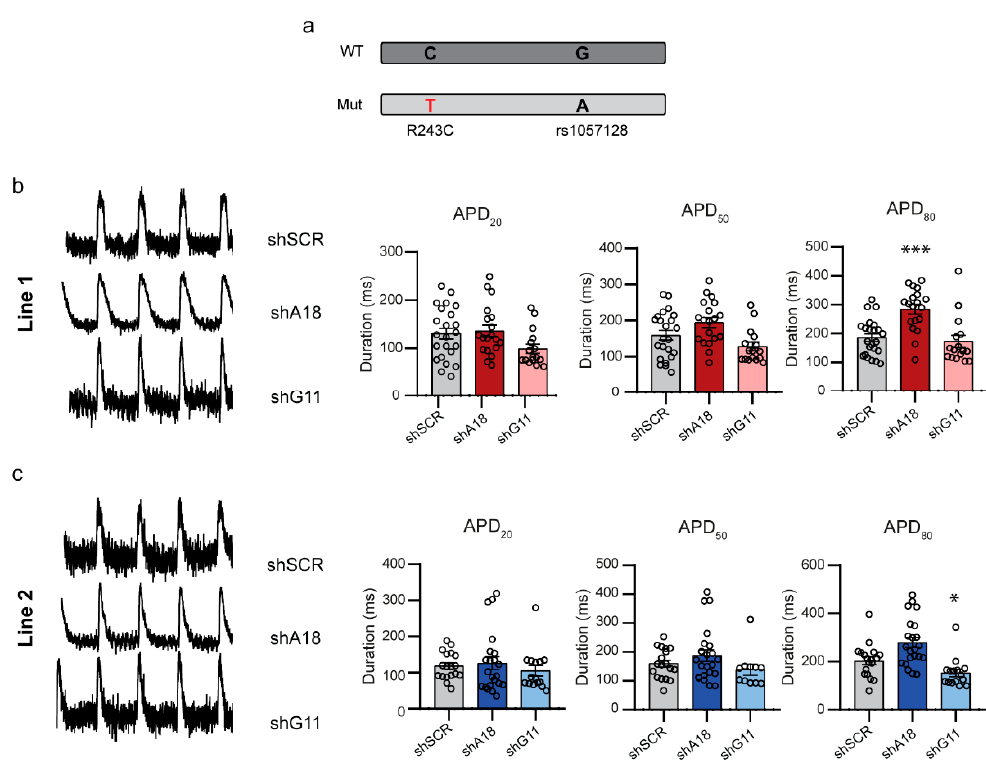
Figure 3. Action potential duration is affected by shifts in allelic balance: ( a ) Schematic representation of the SNP and mutation in KCNQ1 ; ( b , c ) Left, typical recordings of optical action potentials derived from ArcLight fluorescence changes in hiPSC-CMs from Line 1 ( b ) or Line 2 ( c ) treated with either negative control shSCR, shA18 targeting the mutant KCNQ1 allele or shG11 targeting the wild-type KCNQ1 allele stimulated at 1 Hz. Right, action potential duration at 20, 50, or 80% of repolarization (APD 20 , APD 50 , and APD 80, respectively) of optical action potentials of hiPSC-CMs from Line 1 in red ( b ) or Line 2 in blue ( c ). * p < 0.05; *** p < 0.001 compared to shSCR negative control treated hiPSC-CMs; error bars indicate SEM.